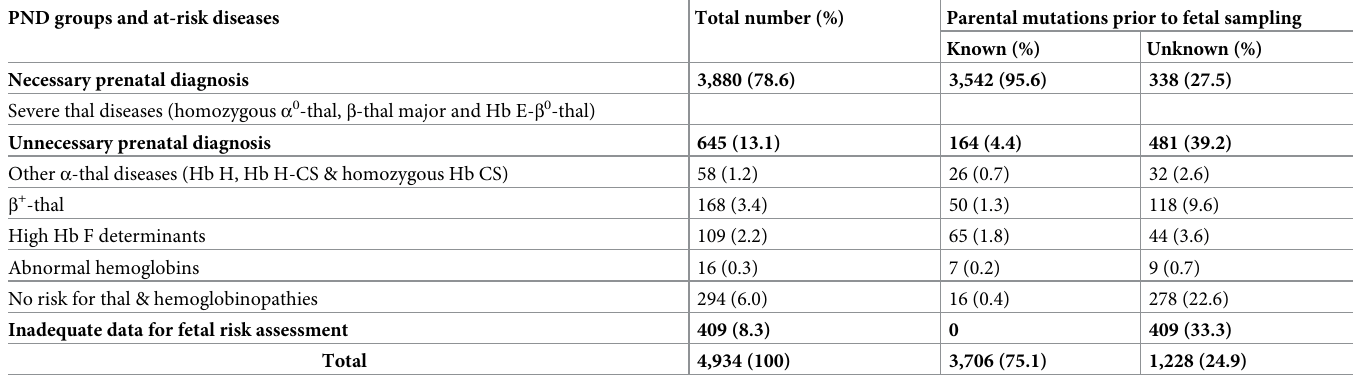
analysis, two samples with suspected non-paternity based on VNTR analysis, and 1 sample with inconsistency results of the fetus and the parents. The remaining 4,934 fetal specimens including CVS (n = 107, 2.2%), amniotic fluid (n = 4,554, 92.3%) and fetal blood (n = 273, 5.5%) were further analyzed. As shown in Table 2 , among these 4,934 PND requests, there Table 2. Numbers of PND requests for hemoglobinopathies during 2009–2021, grouped according to necessary (n = 3,880) and unnecessary (n = 645) requests and requests with inadequate data for fetal risk assessment (n = 409). Numbers of requests with known and unknown parental mutations prior to fetal sampling and the risks for hemoglobinopathies of the fetuses are listed. CS = Hemoglobin Constant Spring, thal =